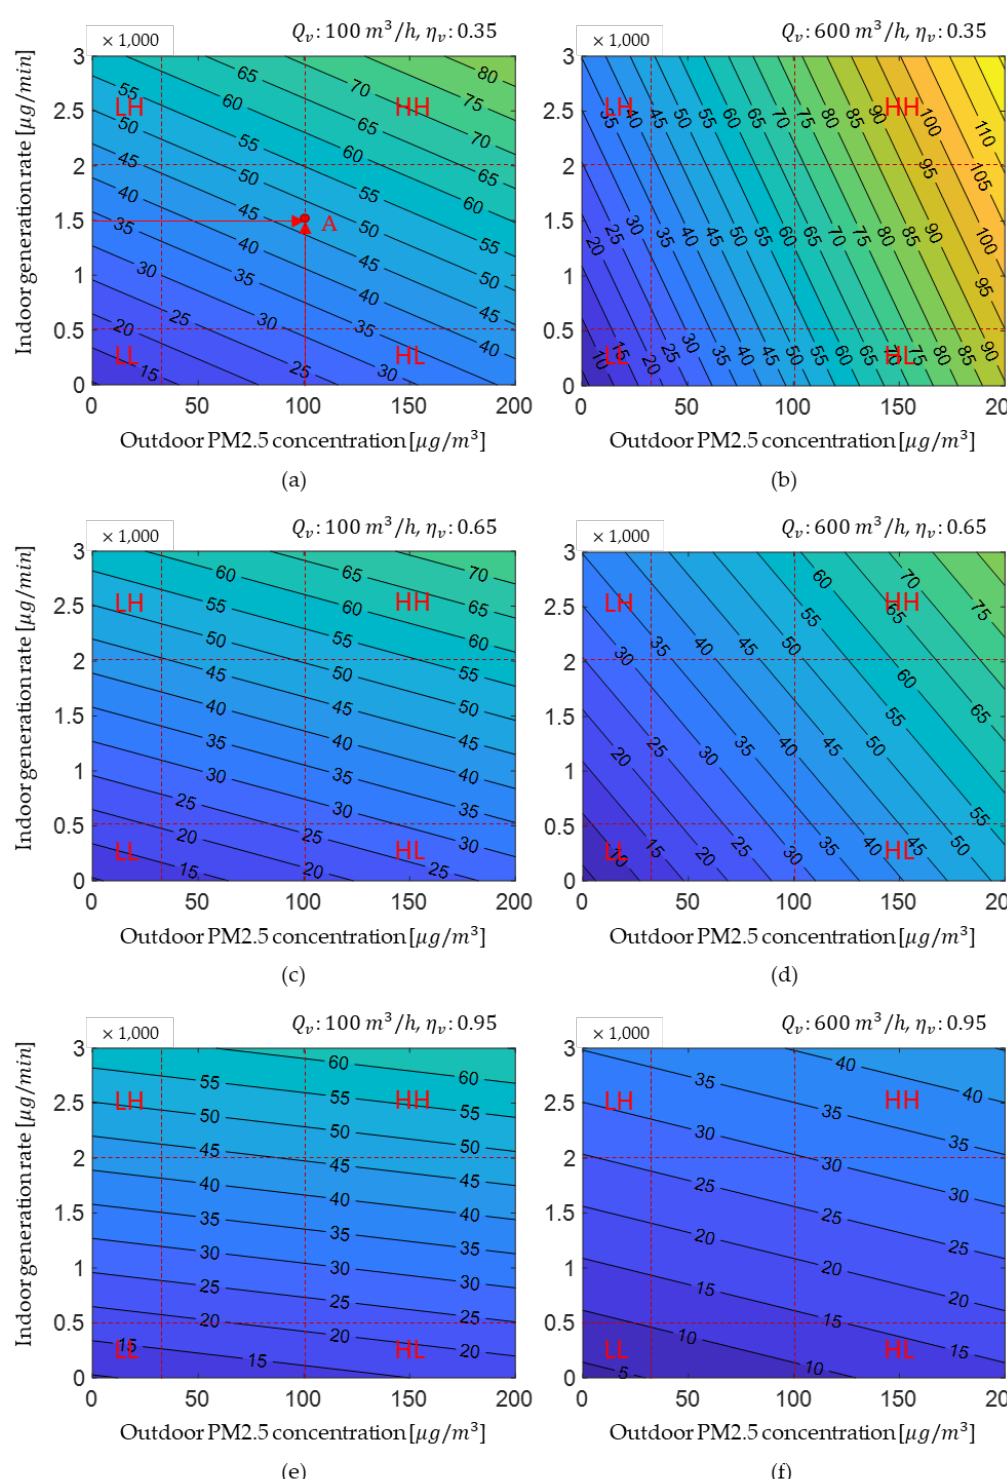
Figure 8. Indoor PM2.5 concentrations when ( a ) 𝑄 𝑉 is 100 m 3 /h and 𝜂 𝑣 is 0.35, ( b ) 𝑄 𝑉 is 600 m 3 /h and 𝜂 𝑣 is 0.35, ( c ) 𝑄 𝑉 is 100 m 3 /h and 𝜂 𝑣 is 0.65, ( d ) 𝑄 𝑉 is 600 m 3 /h and 𝜂 𝑣 is 0.65, ( e ) 𝑄 𝑉 is 100 m 3 /h and 𝜂 𝑣 is 0.95, and ( f ) 𝑄 𝑉 is 600 m 3 /h and 𝜂 𝑣 is 0.95.